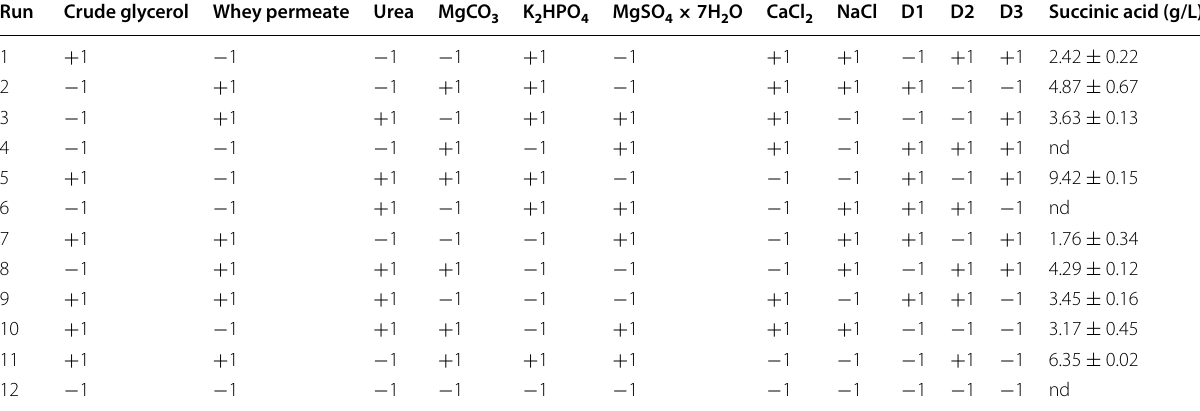
Table 3 Plackett–Burman design for eight variables with the corresponding experimental values of succinic acid concen- tration